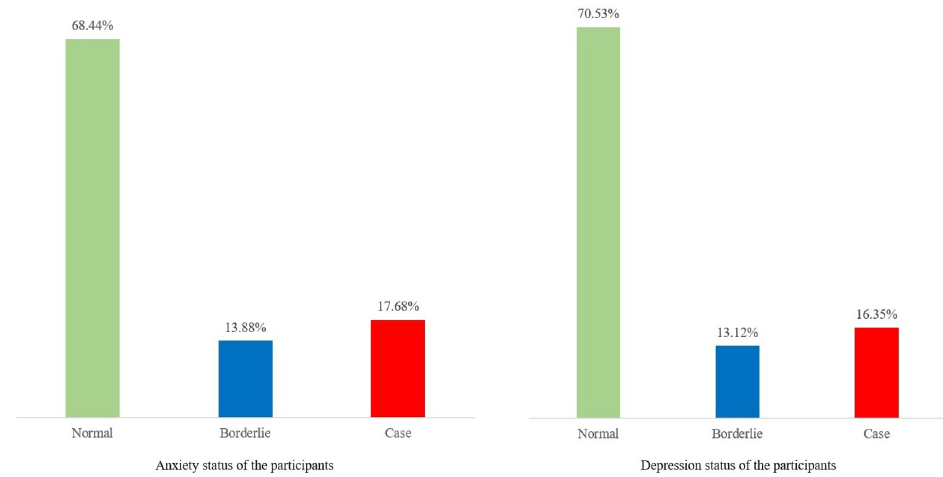
Fig 2. Anxiety and depression status of the participants.